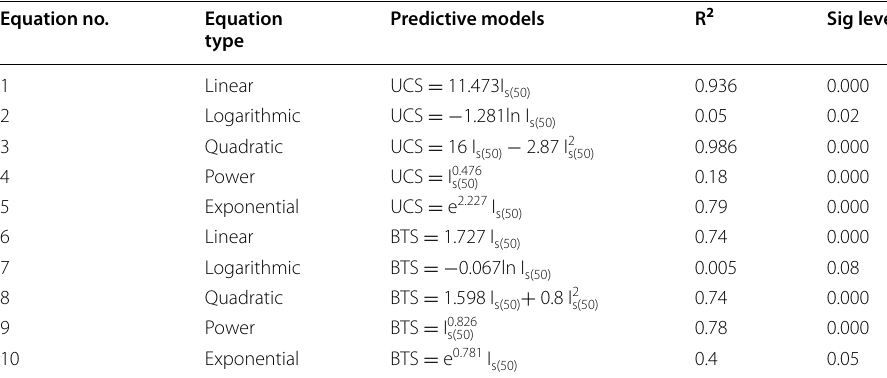
Table 3 Predictive models for assessing the UCS and BTS